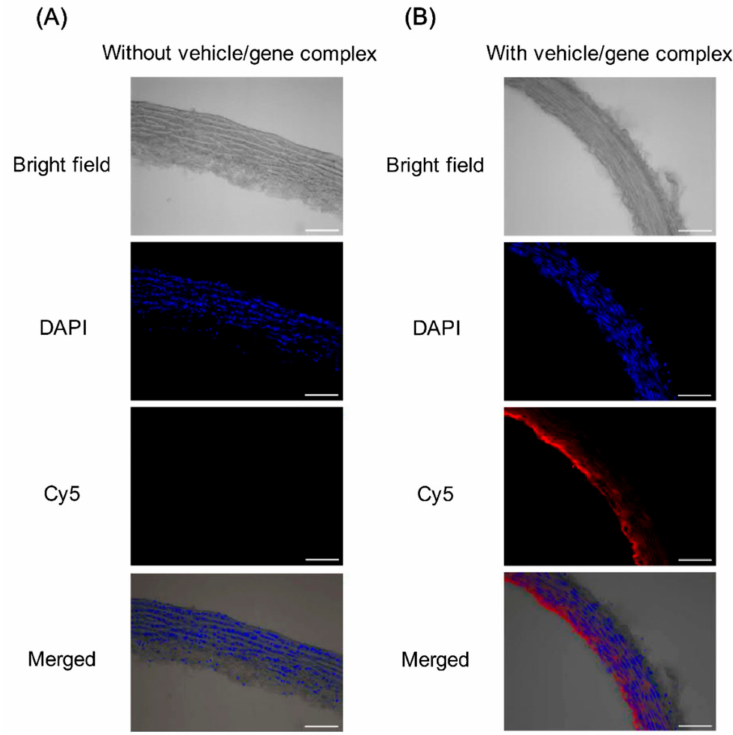
Figure 9. Coating layers ( A ) without and ( B ) with the PEI-Au / CHC / phEGR1-PKC δ complex were coated onto the surface of the percutaneous transluminal coronary angioplasty (PTCA) balloon catheters. phEGR1-PKC δ was stained by Cy5 (a kind of DNA stain). The DNA-incorporated balloon catheters were then attached the inner surface of blood vessels, at a scale bar of 100 µ